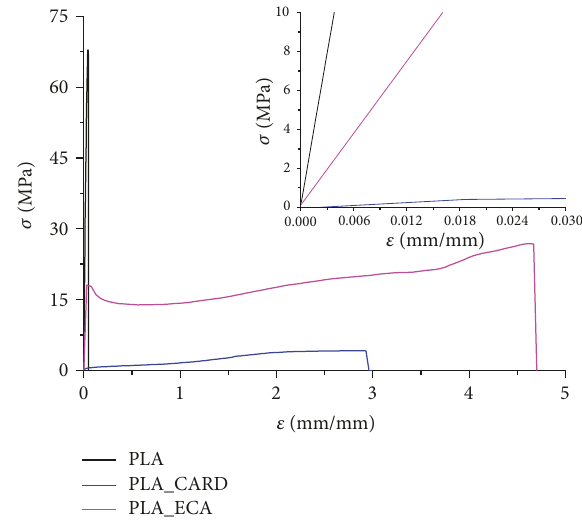
Figure 6: Stress-strain curves of rotational molded plasticized